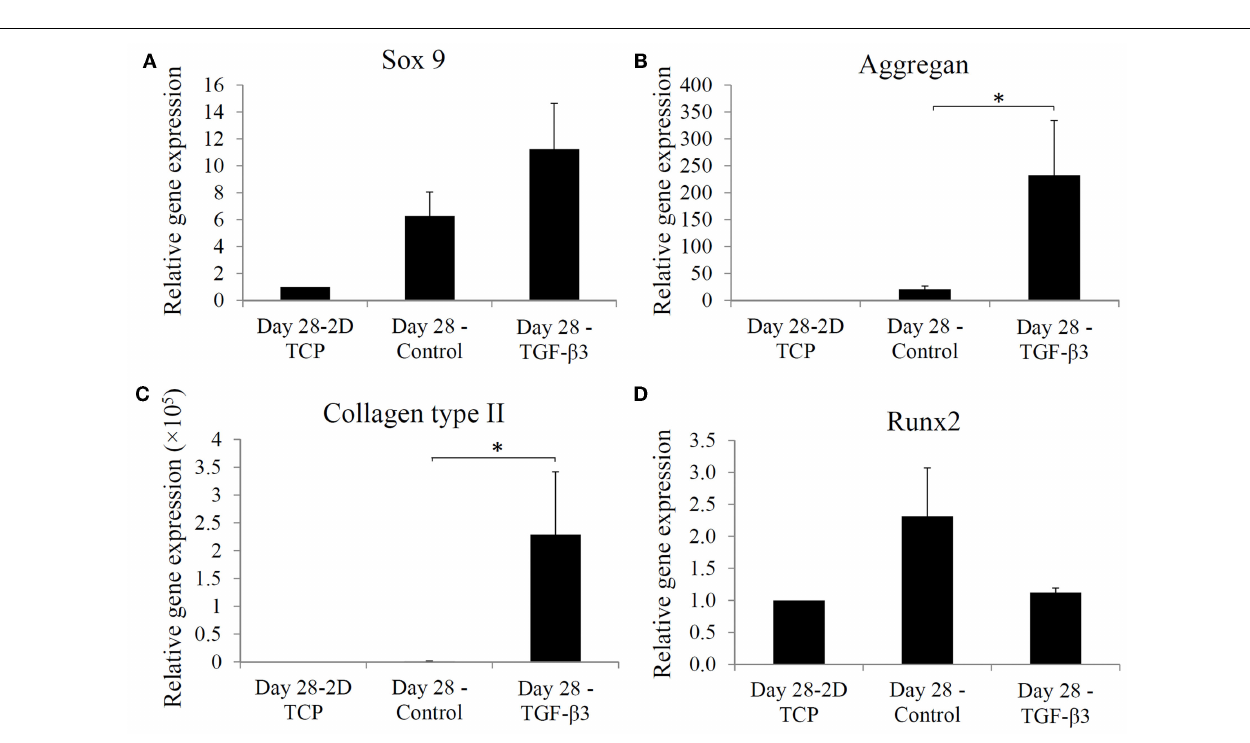
FIGURE 4 | Real time-PCR analysis of gene expression in hASCs at day 28 in 2D tissue culture plate, control group, and TGF- βββ 3 group . Relative gene expression levels of (A) Sox 9, (B) aggregan, (C) collagen type II, and (D) Runx2 at day 28, are normalized to gene expression in 2D culture without chondrogenic induction. * p <